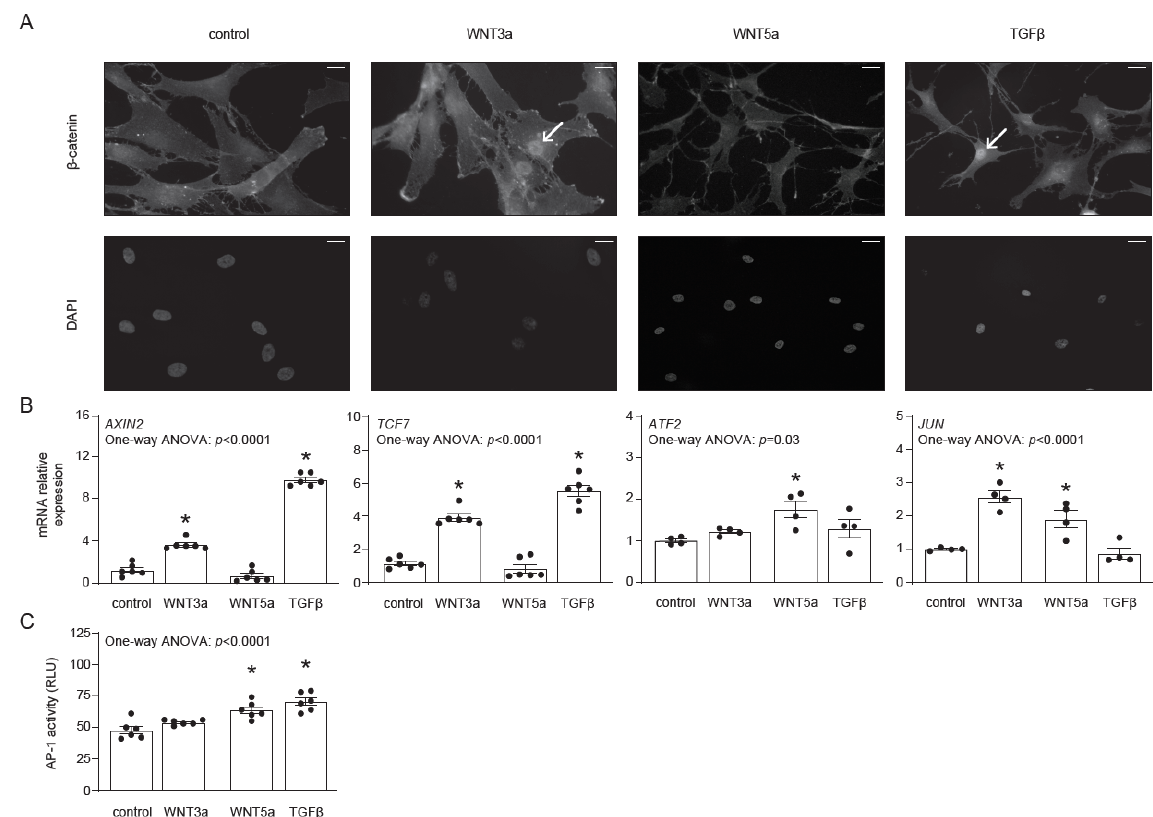
Figure 1. Activation of canonical and non-canonical WNT pathways in human cardiac fibroblasts. Human cardiac fibroblasts were stimulated with WNT3a, WNT5a or TGF- β . Panel ( A ) illustrates cellular localizations of β -catenin in fibroblasts 30 min after indicated treatment. DAPI stains cell nuclei. Arrows indicate nuclear localization of β -catenin. Data are representative of three independent experiments. Bar = 50 µ m. Panel ( B ) represents expression of canonical ( AXIN2 and TCF7 ) and non-canonical ( JUN and ATF2 ) WNT responsive genes 1 h after indicated treatment. Panel ( C ) shows quantification of AP-1 activity in AP-1-hCF reporter cardiac fibroblasts following 24 h treatment ( n = 6). Graphs show means ± SEM, p values computed using one-way ANOVA followed by Dunnett’s multiple comparisons test, * p < 0.05 (post-hoc test vs. control).